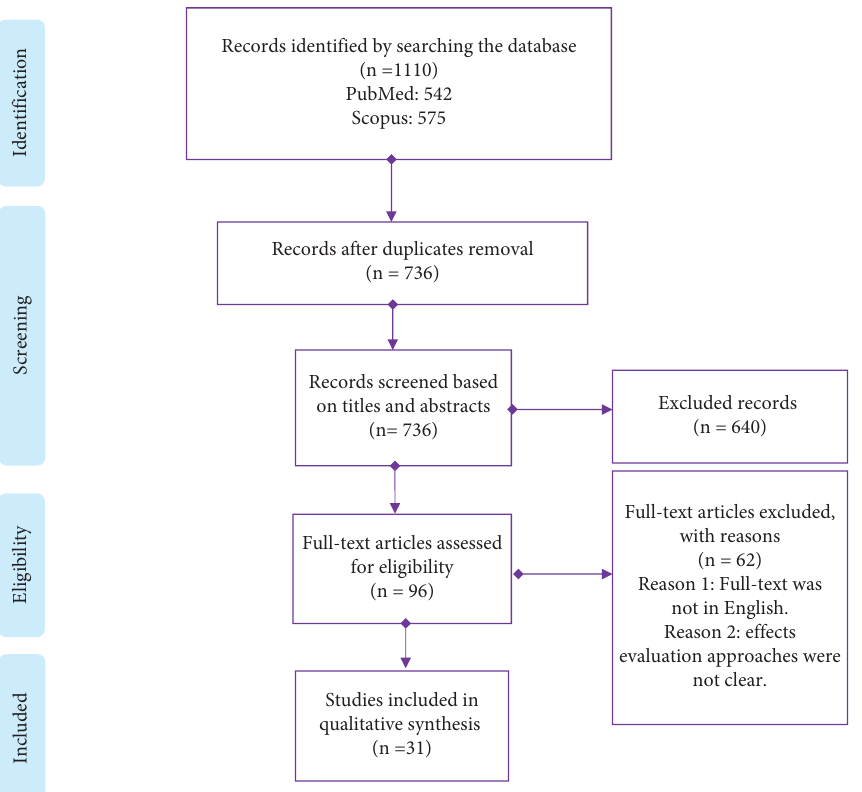
Figure 1: Te fow diagram of determining, selecting, and screening papers based on PRISMA.